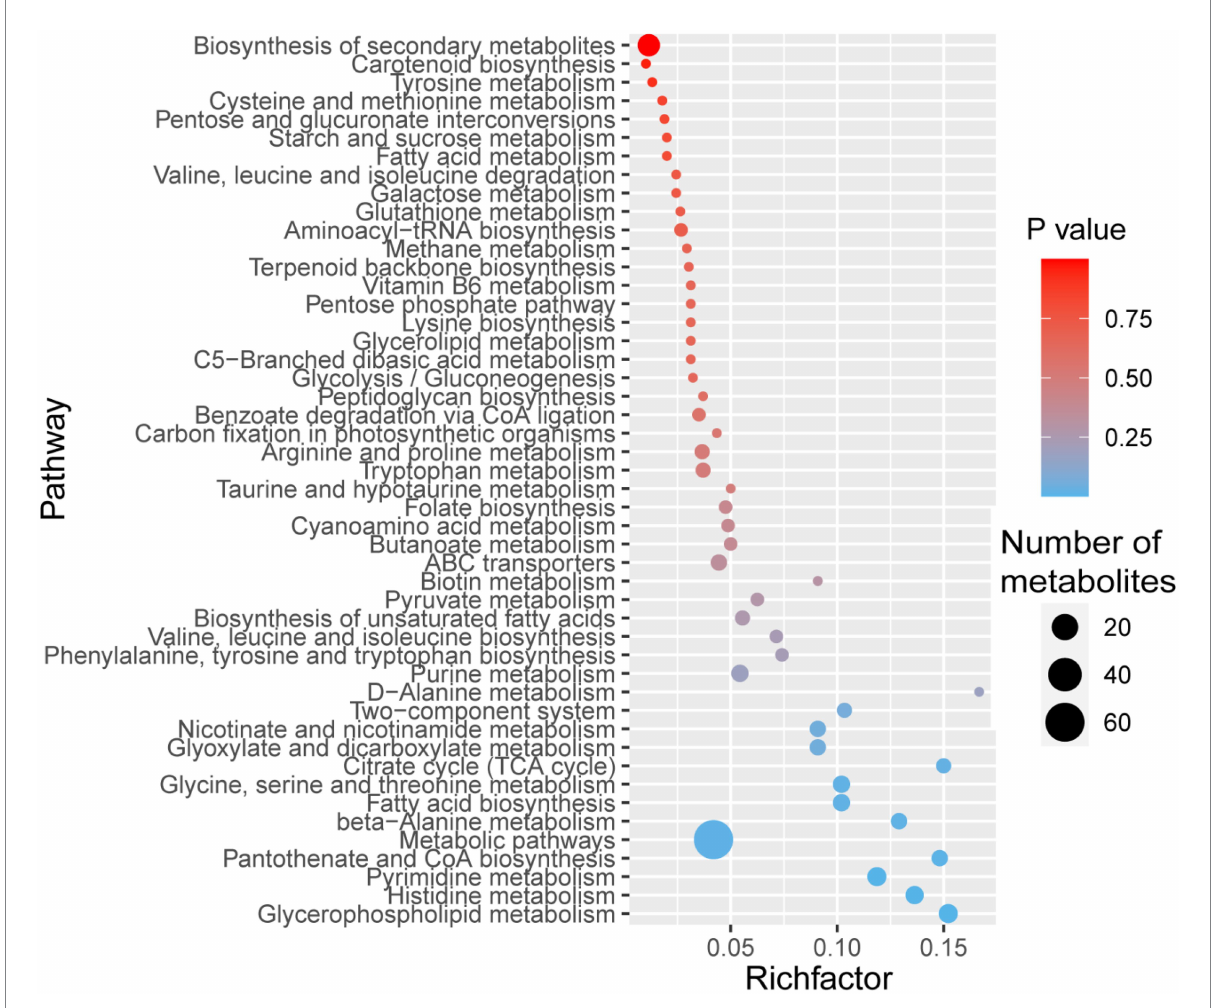
FIGURE 2 Bubble diagram showing KEGG pathway annotation covered by 409 metabolites. The x-axis indicates the scale of the “Rich factor” (the ratio of the number of metabolites in the corresponding pathway to the total metabolites annotated by the pathway detection) of the pathway in topological analysis, while the y-axis presents individual pathways. The color of the bubble indicates the p value of enrichment analysis with darker colors having a lower p value and greater enrichment. Size of the bubble is proportional to the number of metabolites in this